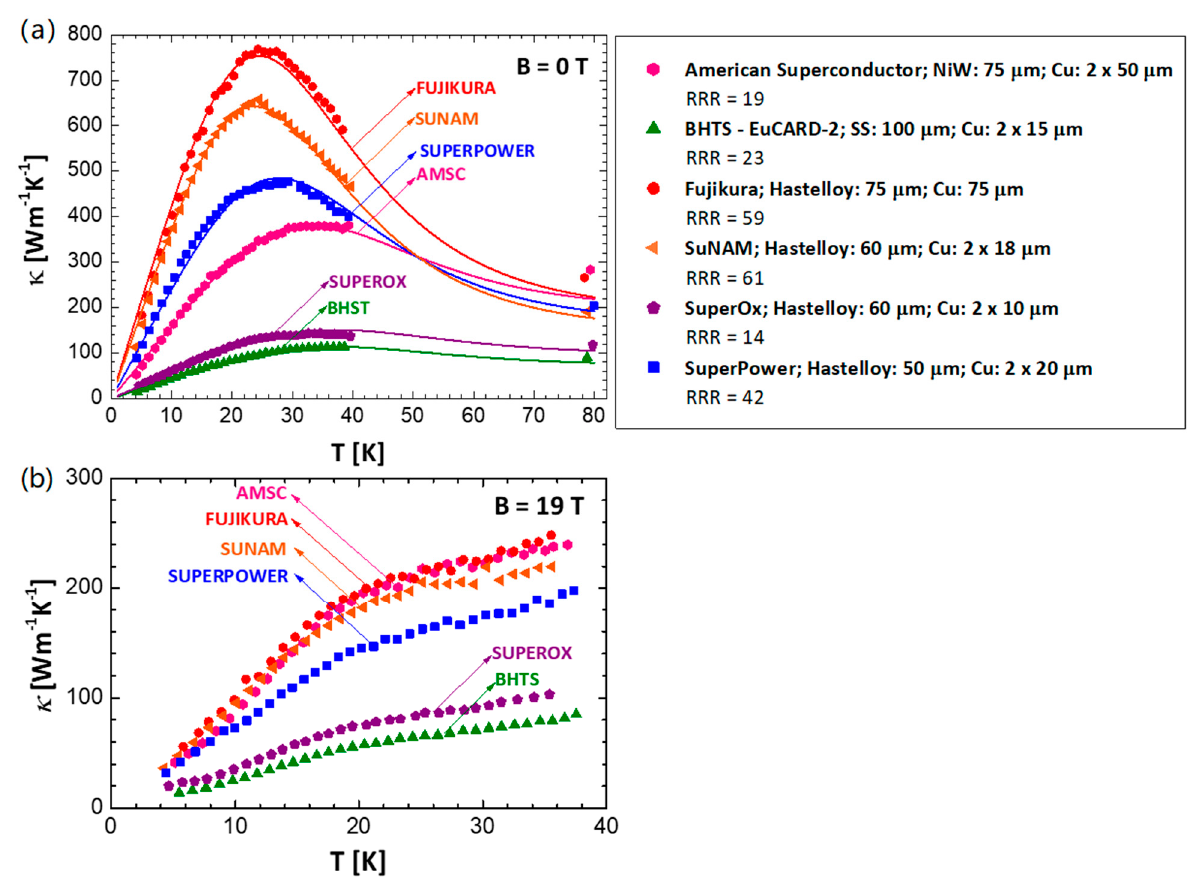
Figure 13. Temperature dependence of the thermal conductivity of REBCO tapes from six industrial manufacturers at B = 0 T ( a ) and B = 19 T ( b ). Adapted from Ref. [52].